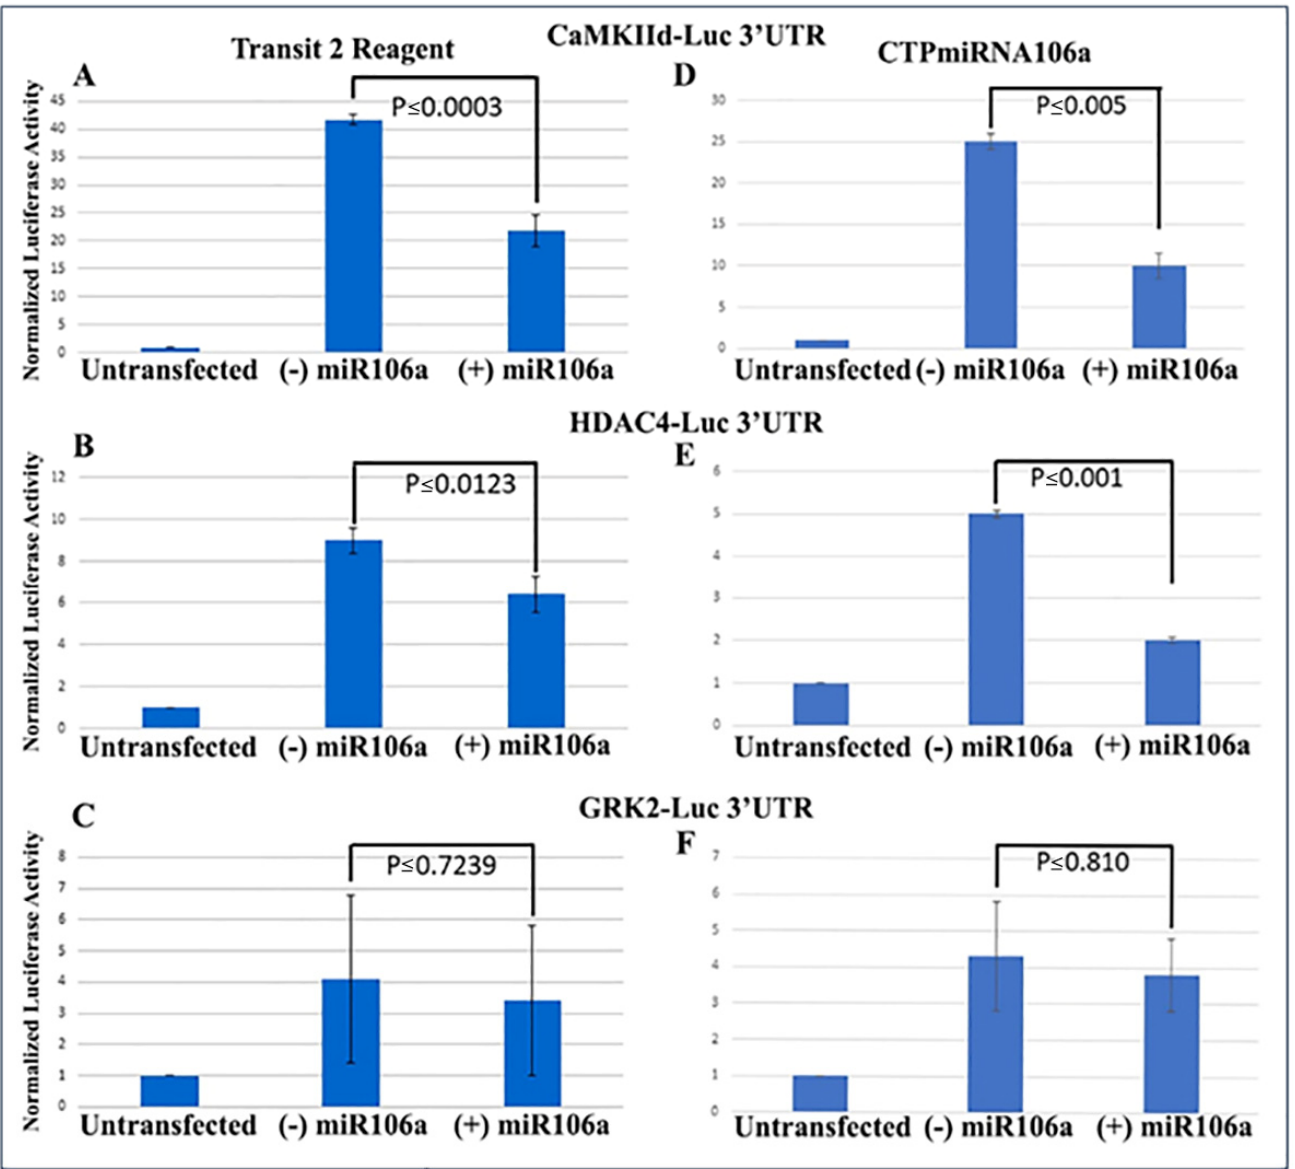
Figure 2. 3 ′ UTR-luciferase assays confirm miRNA targets. ( A – C ) CamKII δ ( A ), HDAc4 ( B ) and GRK2 ( C ) 3 ′ UTR-luciferase constructs were transfected using Mirus Transit2 reagent, followed 24 h later transfection using Mirus Transit2 of miRNA106a. Luc activity was significantly decreased for both CamKII δ and HDAc4 but not GRK2 (GRK2 is not a target of miRNA106a). ( D – F ) Similar to ( A – C ), each 3 ′ UTR construct was transfected using Mirus Transit2; however, the CTPmiRNA106a was added 24 h later without a transfection reagent. Significant reductions in CamKII δ and HDAc4 were observed but not GRK2. n = 6 for each experiment.